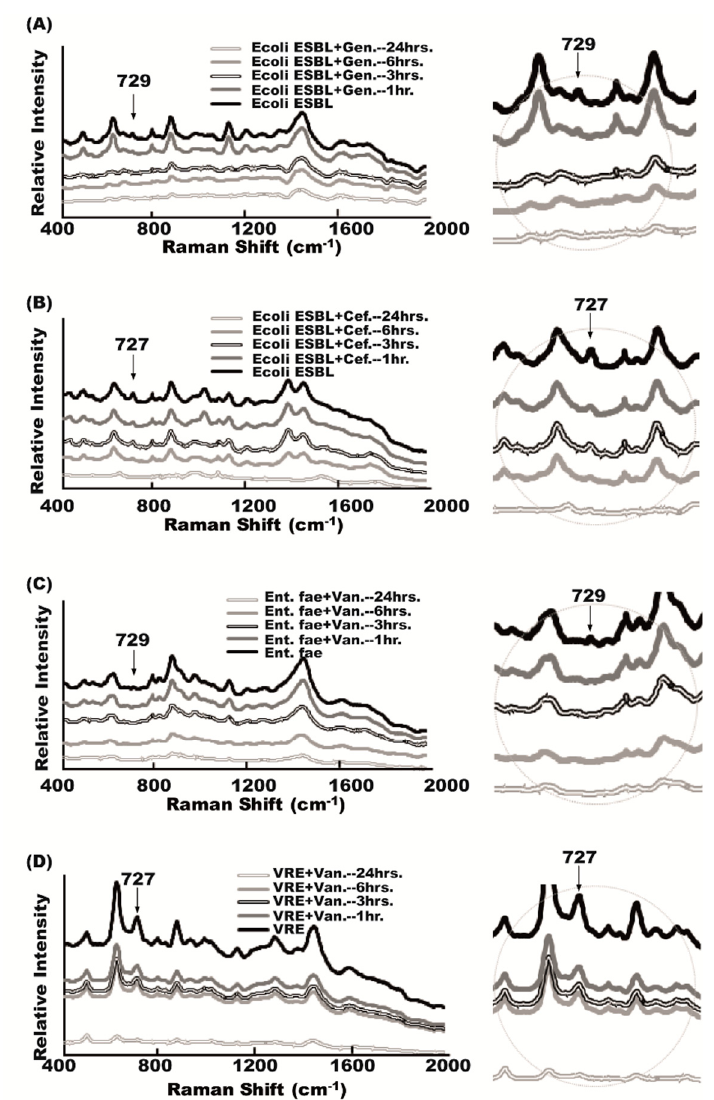
Figure 6. Antibiotic effects on bacterial-specific Raman signal. ( A ) 729 cm − 1 signal peak of Raman spectrum time-dependently disappeared after gentamicin (Gen.) treatment in gentamicin-susceptible E. coli ESBL (gentamicin concentration: 0.256 mg/L); ( B ) E. coli -specific 729 cm − 1 signal persisted in cefazolin (Cef.)-resistant E. coli ESBL . (cefazolin concentration: 0.256 mg/L); ( C ) Enterococcus -specific 727 cm − 1 signal gradually disappeared after vancomycin treatment in vancomycin-susceptible Enterococcus faecalis (vancomycin concentration: 32.1 mg/L); ( D ) Enterococcus -specific 727 cm − 1 signal persisted in VRE (vancomycin concentration: 0.256 mg/L).